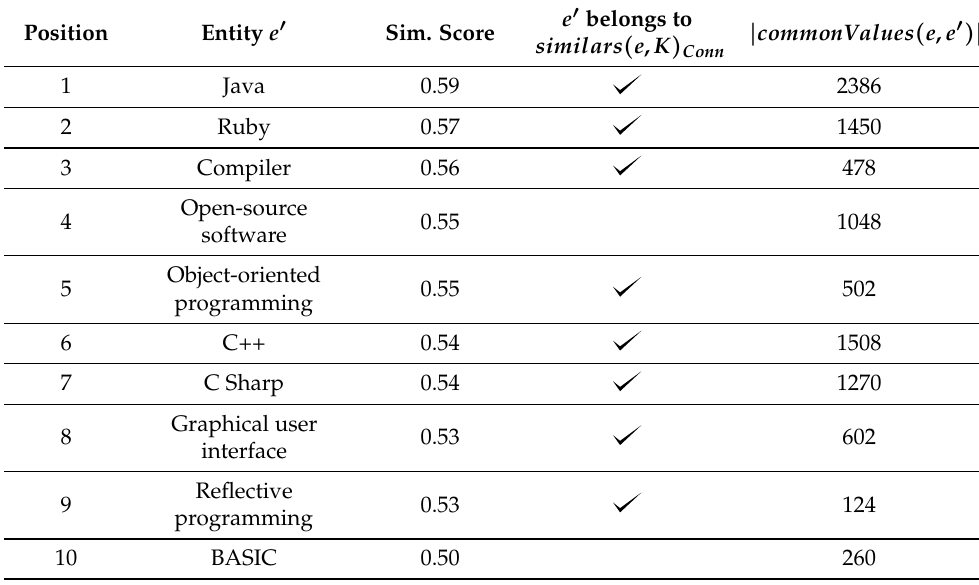
Table 6. Similarity Measurements for the top-10 similar entities to Python Programming Language.